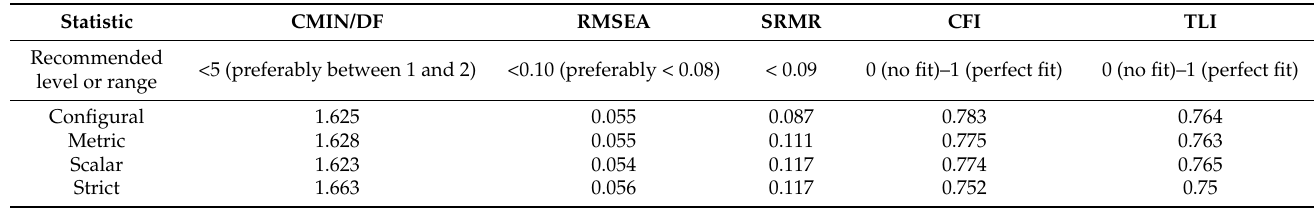
Table 3. Results of the measurement invariance